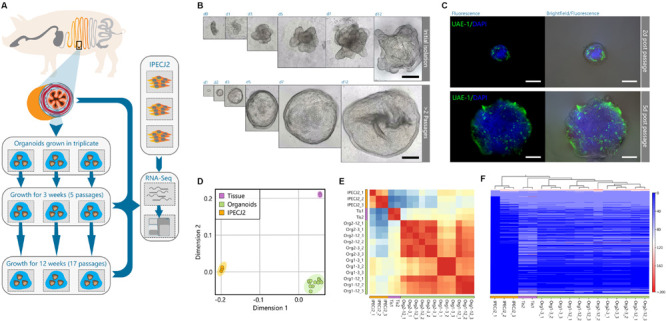
Porcine intestinal organoid culture and transcriptome sequencing overview. (A) graphical overview of the study design. Organoids were generated from the jejunum of two individual pigs, directly divided into triplicate organoid cultures per animal, and passaged for 12 weeks. Total RNA of tissue, organoids, and jejunum cell line IPEC-J2 was extracted and sequenced by RNA-seq. (B) Initially after isolation, intestinal crypts form budding organ-like structures in vitro. Within 2 weeks of passaging, organoids form more spheroid-resembling structures for the remainder of the experiment, indicating more long-term reproducibility after a short-term series of passaging. (C) After 12 weeks of growth, spheroids still retain secretory cell lineage differentiation early post-passaging (green: stained with UEA-1). (D) Multidimensional scaling of transcriptomic data showed separation of organoids, tissue and IPEC-J2, where organoids and tissue show separation in only one dimension. (E) Correlation matrix of all samples show high correlation among individual organoid batches, and strong correlation between tissue. (F) Heat map and hierarchical clustering of all expressed genes (>1 FPKM) in the dataset.